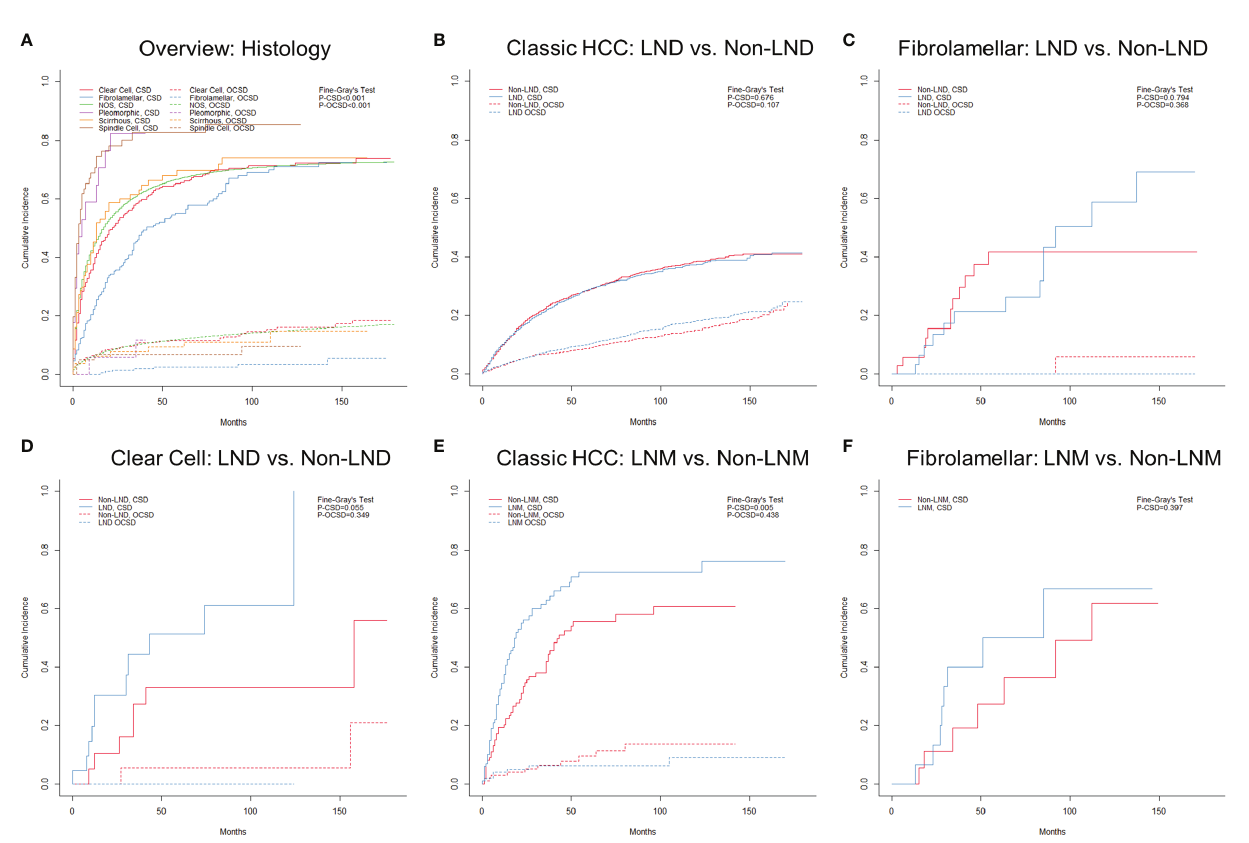
FIGURE 5 | Cumulative incidence function curves of mortality in hepatocellular carcinoma patients strati fi ed by different factors: (A) histology and (B – F) nodal status. LND, lymph node dissection; LNM, lymph node metastasis; CSD, cancer-speci fi c death; OCSD, other cause-speci fi c